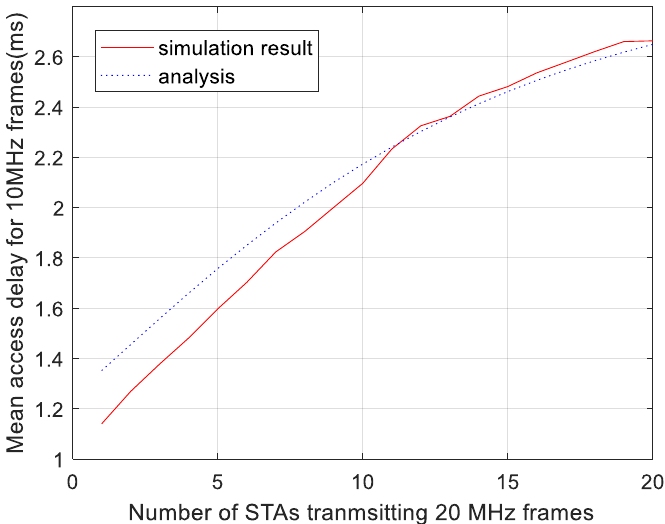
Figure 8. Comparison between analysis and simulation, in terms of the mean access delay of 10 MHz transmissions in the secondary channel.